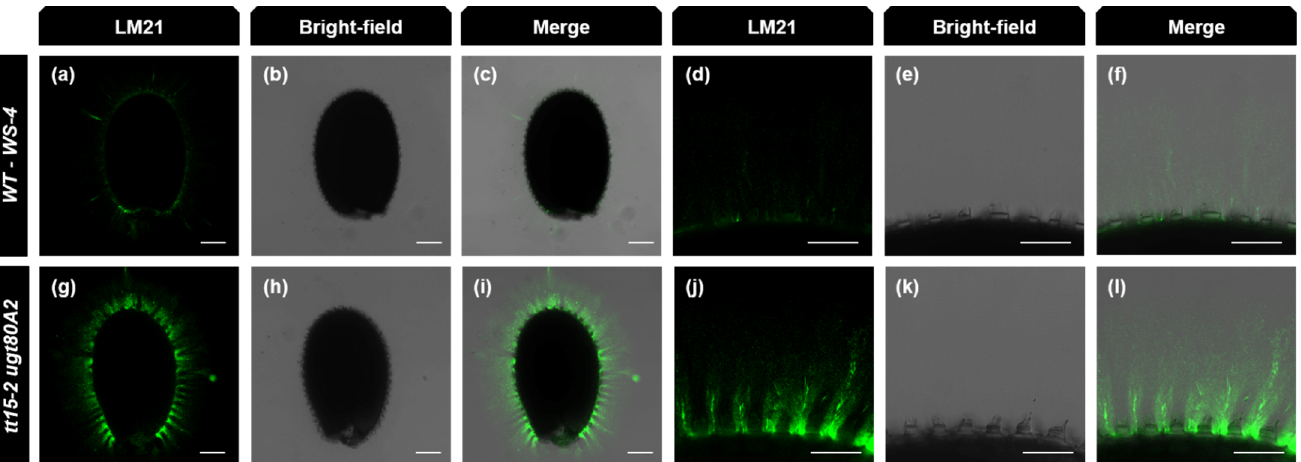
Figure 8. The production of mucilage polysaccharides is modified by mutation of TT15 and UGT80A2 . ( a ) Mucilage was extracted sequentially from intact seeds and GalA amounts determined for outer water-extracted mucilage (coloured bars) or RGase hydrolysates of inner mucilage (white bars). Error bars are SE ( n = 3) for biological replicates. Dunnett pairwise comparison to wild type, *** p < 0.01. ( b ) Minor sugar contents. Error bars are SE ( n = 3–12). ( c ) cellulosic glucose contents in total mucilage extracted by sonication. Error bars are SE ( n = 6). In ( b , c ), significant differences from wild type (Kruskal-Wallis test, * p < 0.1, *** p < 0.001). Wild type, WT; tt15-2 ugt80A2-3 , tt15-2 A2, NC-Glc, non-cellulose derived glucose, C-Glc, cellulose-derived glucose. All genotypes are in the Ws-4 background.